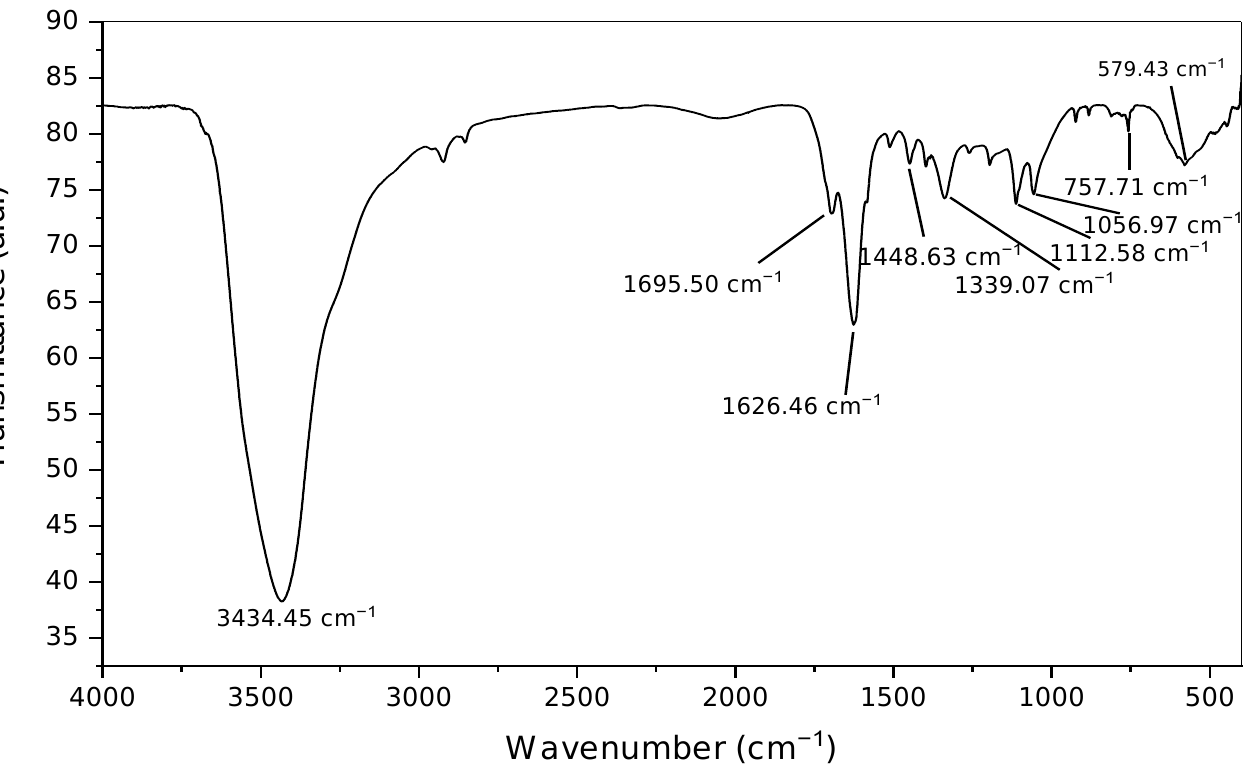
Figure 5. FTIR spectrum of the biogenic silver nanoparticles synthesized utilizing Punica granatum peel extract. Table 1. Functional groups of silver nanoparticles fabricated using aqueous peel extract of Punica granatum